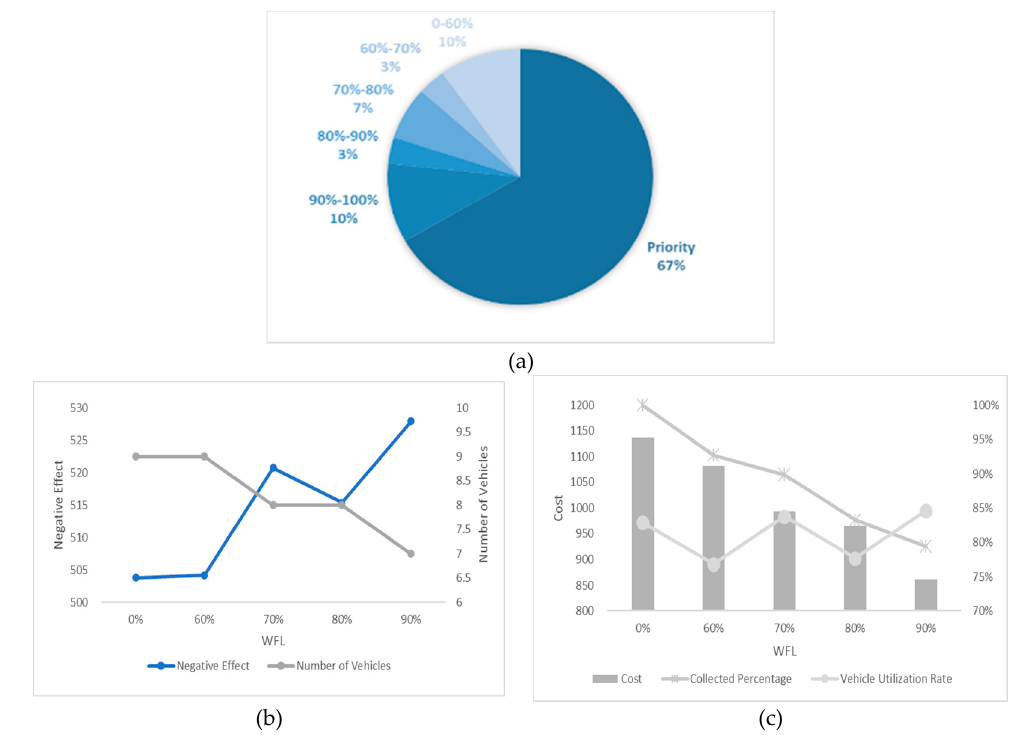
Figure 14. Results with 15 high-priority waste bins. ( a ) PCS-15 distribution of various waste bins, ( b ) PCS-15 negative effect and number of vehicles and ( c ) PCS-15 cost and vehicle utilization rate.